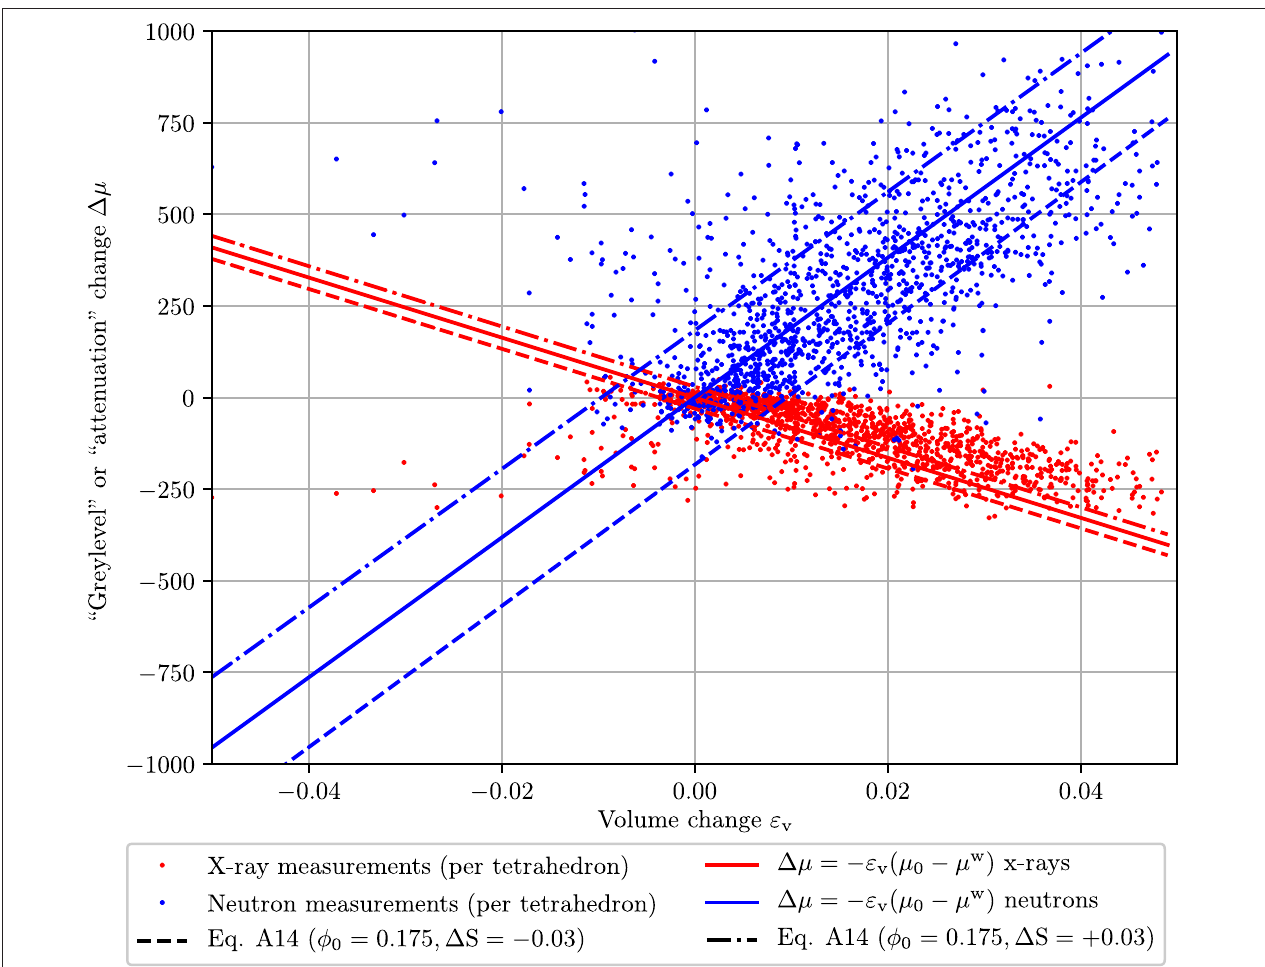
FIGURE 8 | Data from Global DVC on increments 002-020, 002-039, and 002-0045. Volumetric strain of each tetrahedron plotted against the measured greylevel change in each tetrahedron. Expected changes of greylevel due only to the solid are added as per Equation (12). These scattered values for x-rays and neutrons are fitted with a linear regression